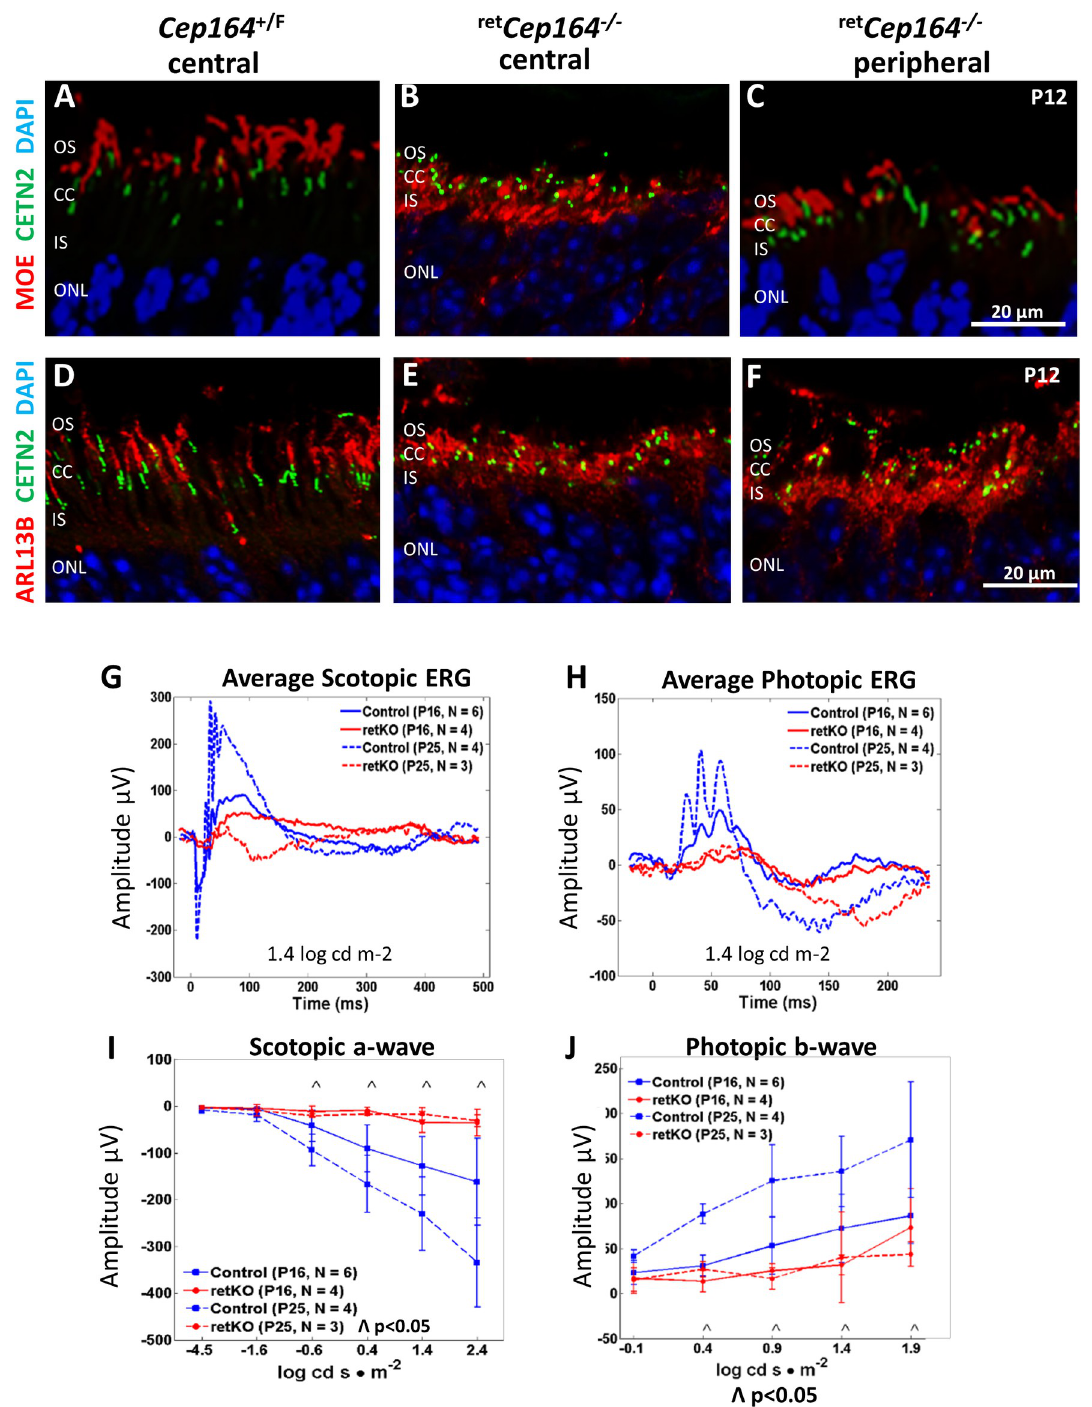
Fig 2. Central ret Cep164 -/- photoreceptors do not form OSs. A-C , P12 central Cep164 +/F (A), central ret Cep164 -/- (B) and peripheral ret Cep164 -/- retina cryosections(C) probed with MOE (anti-PDE6) (red). PDE6 is an OS protein participating in phototransduction. In central ret Cep164 -/- sections (B), OSs are not formed and PDE6 mislocalizes to the IS. In retina periphery (C), degeneration is delayed and some OSs are present. D-F , cryosections as in A-C probed with anti-ARL13B, a small GTPase present in the OS. In controls (D), ARL13B correctly localizes to OSs, whereas it mislocalizes to photoreceptor IS of central and peripheral ret Cep164 -/- retina. G-J , Electroretinography (ERG) at P16, P25. Average scotopic ERG (G) and photopic ERG (H) in control (blue) and retina knockouts (red) at 1.4 log cd s m -2 . Scotopic a- wave (I) and photopic b-wave (J) amplitudes ( μ V) as a function of light intensity (log cd s m -2 ).